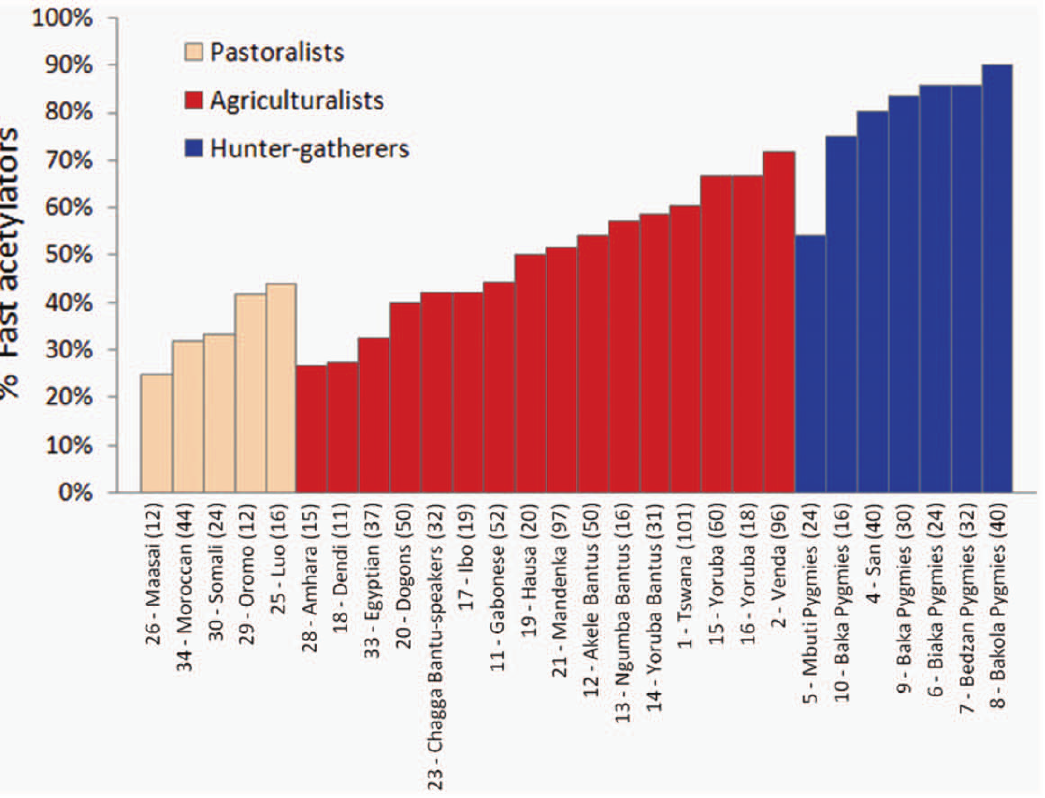
Figure 4. Prevalence of fast acetylators in African population samples. Samples are numbered as reported in Table S1 (‘sample ID’) and sample sizes (number of individuals) are indicated in brackets.